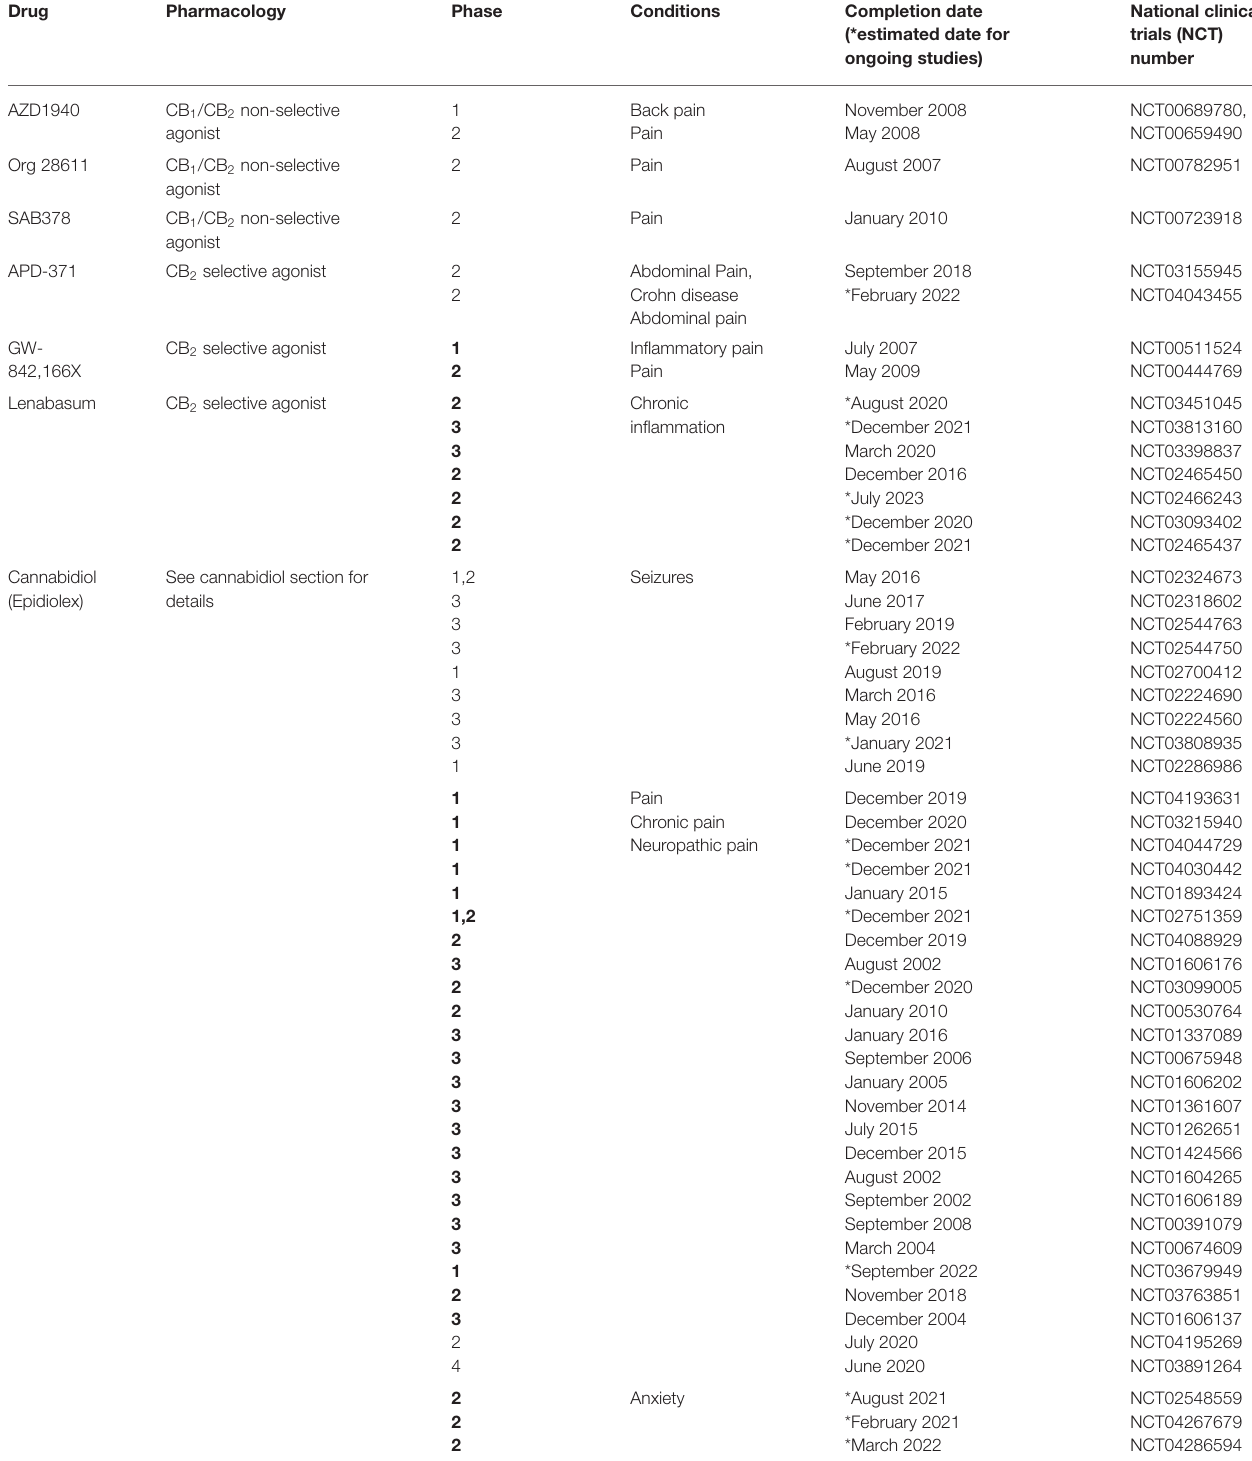
TABLE 1 | Major clinical trials based on pharmacological treatment targeting the endocannabinoid system (updated to July 21, 2020).